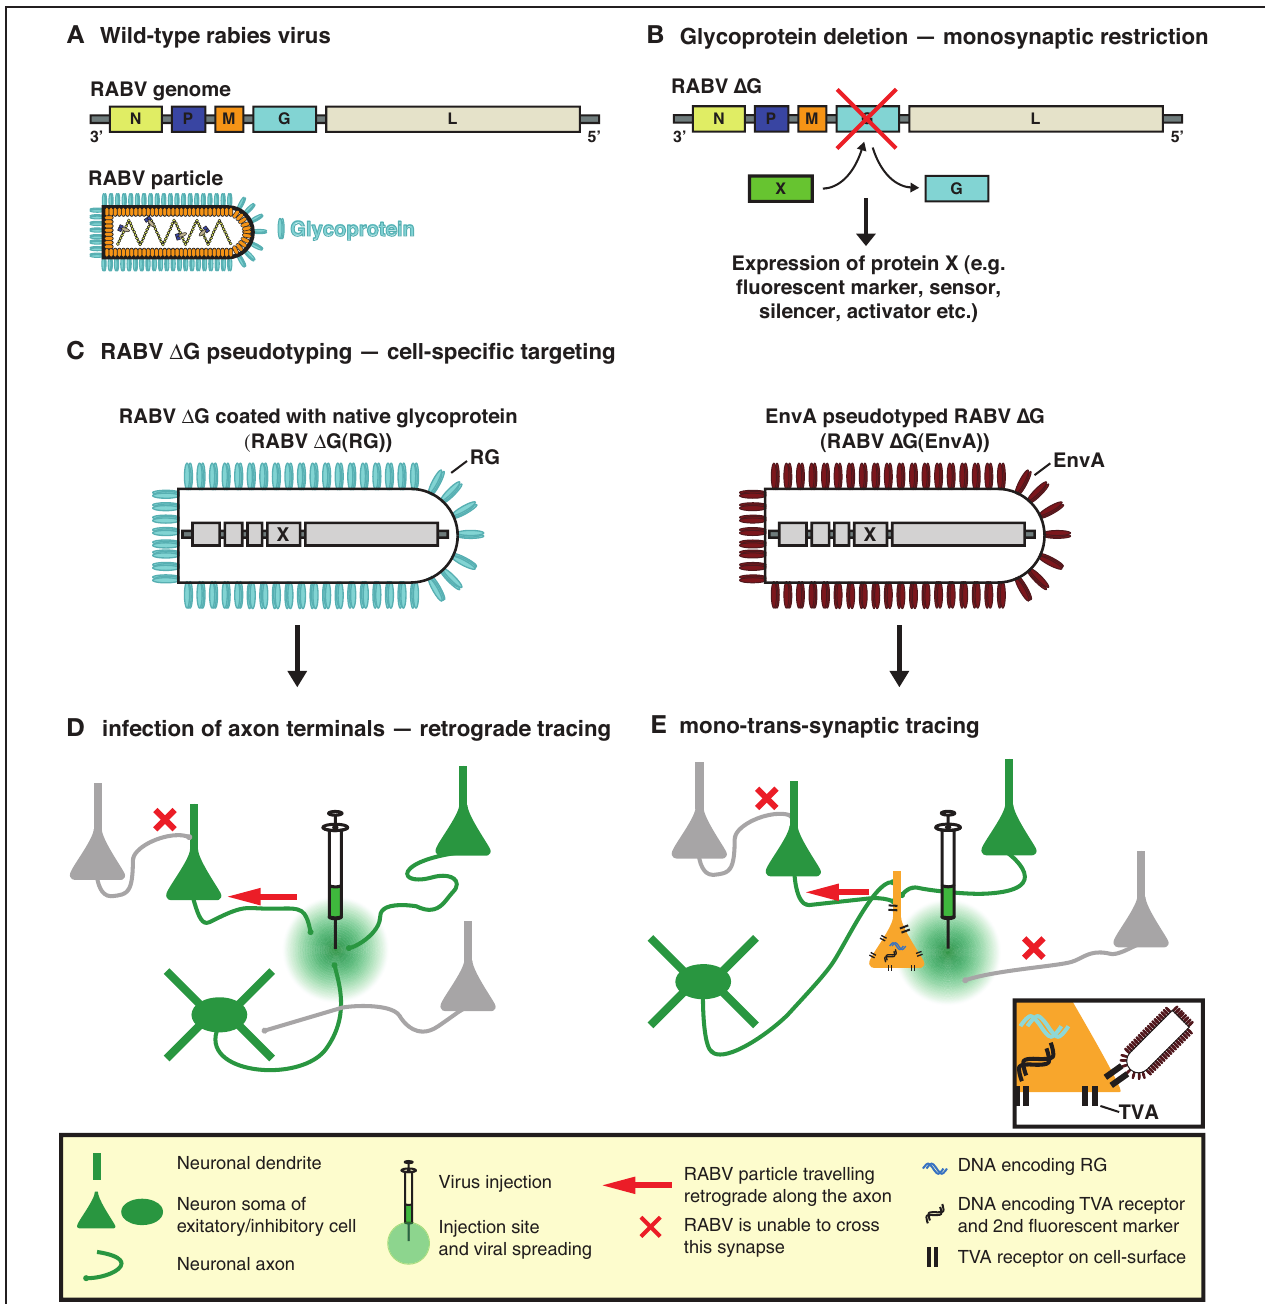
FIGURE 1 | RABV—the trans-synaptic tracing toolbox. (A) The RABV genome encodes five proteins including the envelope glycoprotein (G). (B) Deletion of G ( (cid:2) G) is sufficient to prevent trans-synaptic spreading and results in a single-cycle vector. A gene of interest can then be inserted in the place of the deleted G. This gene of interest can encode a fluorescent protein such as GFP, permitting the visualization of virally traced neurons. It can also permit the expression of an almost unlimited choice of genetically encoded tools for the manipulation/visualization of neuronal circuits, e.g., biosensors, synapse markers, activators/repressors of neuronal activity. (C) RABV (cid:2) G can be pseudotyped, either with its native glycoprotein or an engineered surface protein (e.g., EnvA). Pseudotyping restores the normal infection capabilities